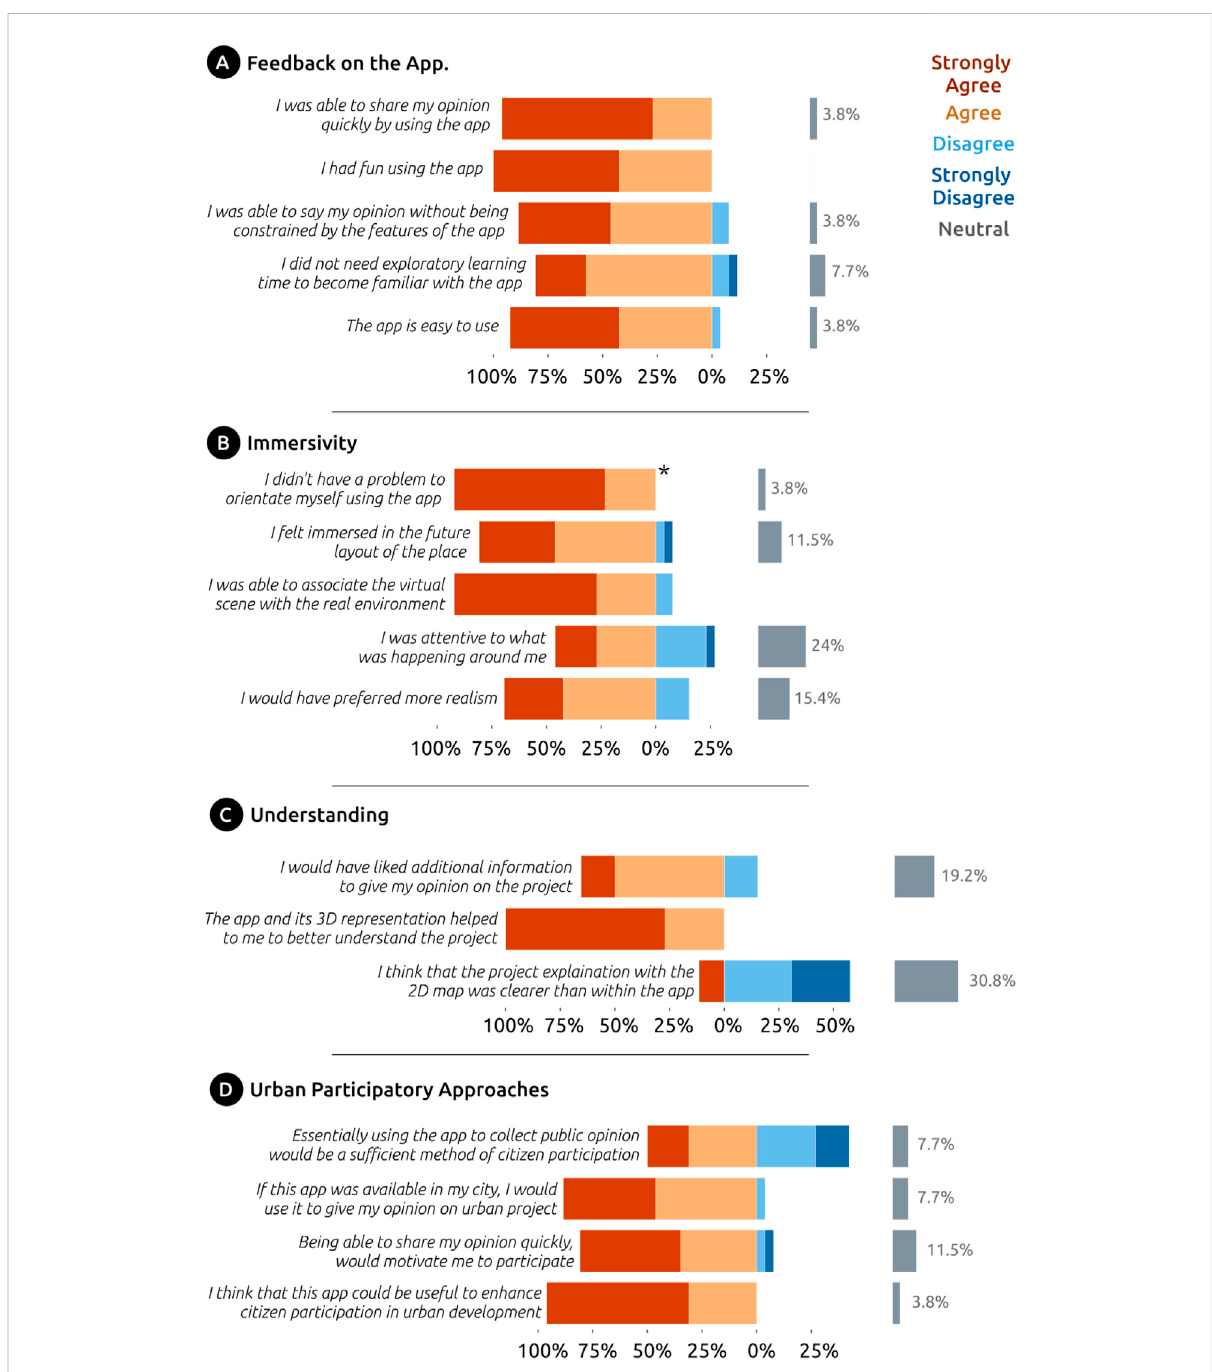
FIGURE 7 Results of the survey, portrayed on a Likert scale. * Answered as non-applicable by one of the participants. (A) Feedback on the app, (B) Immersivity. (C) Understanding. (D) Urban participatory